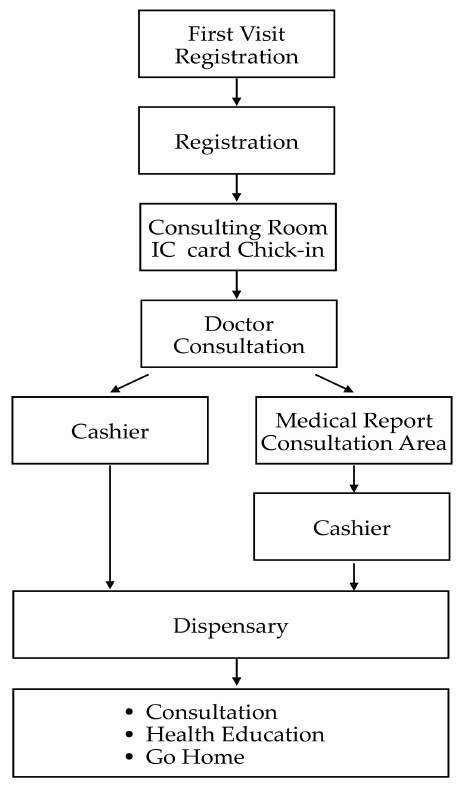
Figure 3. Out-patient care